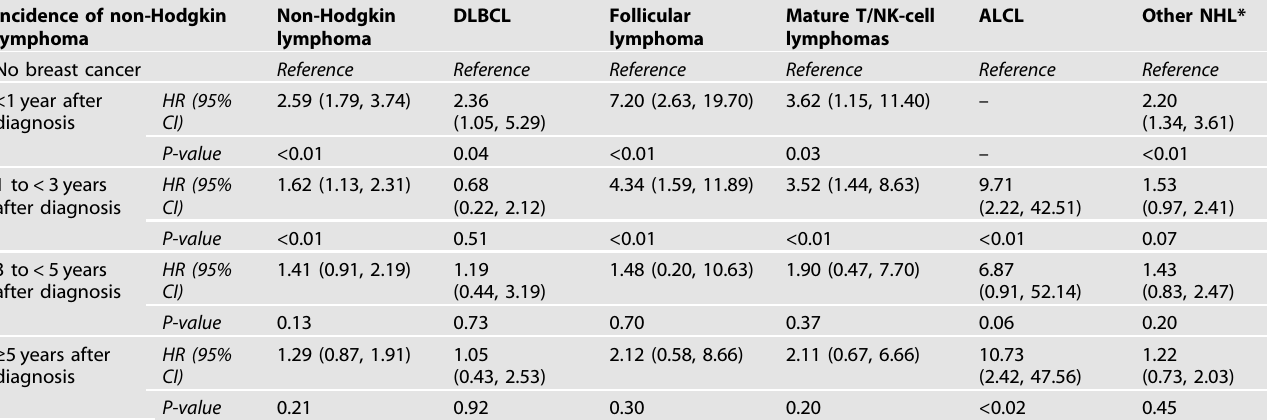
Table 3. Association of incident NHL with incident breast cancer according to the time after